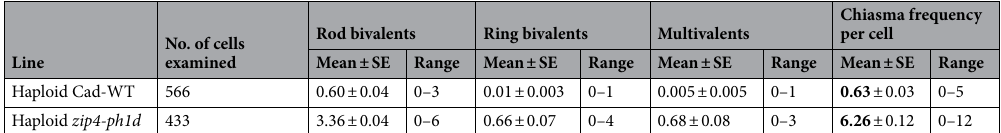
Table 2. Frequencies of rod bivalents, ring bivalents, multivalents and total chiasmata in the haploid Cadenza wild type (Cad-WT) and haploid Cadenza zip4-ph1d mutant. Mean number per cell and range of variation between cells are